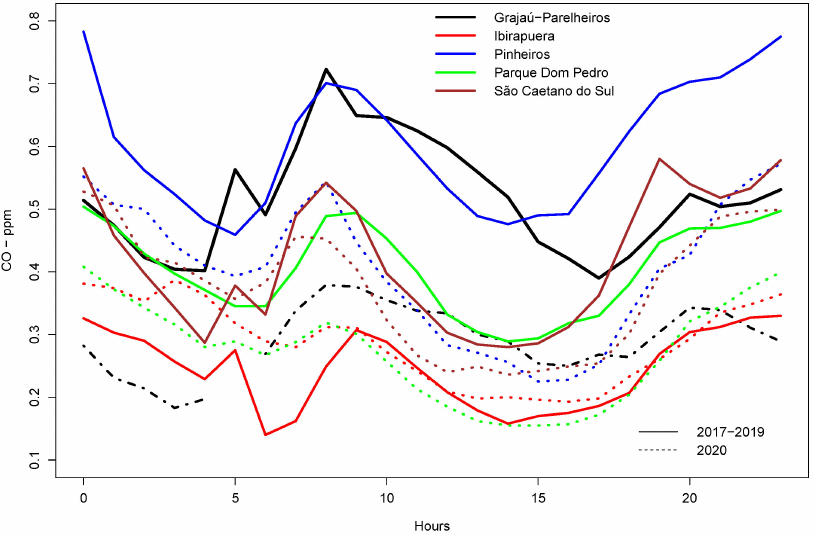
Figure 7. CO hourly concentrations for MASP during April–May 2017–2019 (pre-pandemic) and 2020 (during the pandemic) from ground-level